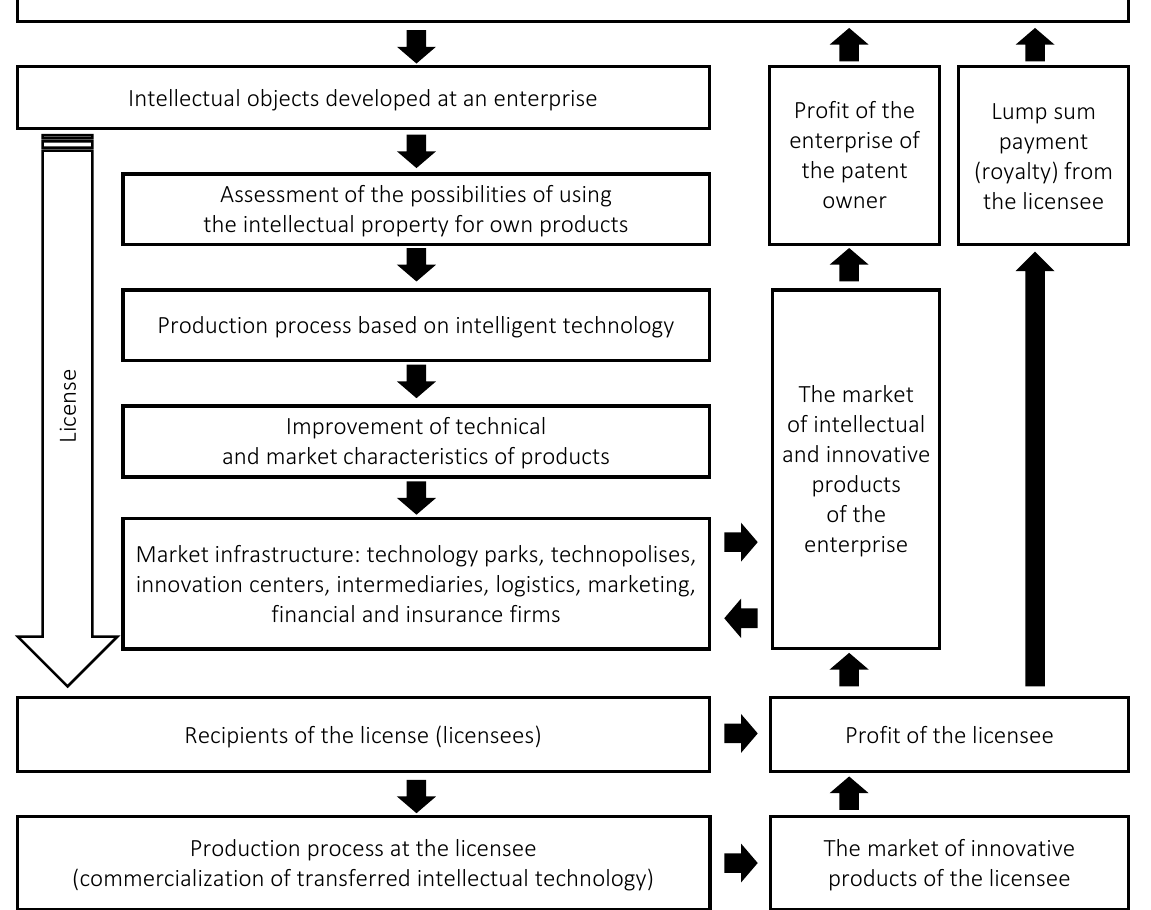
Recipients of the license